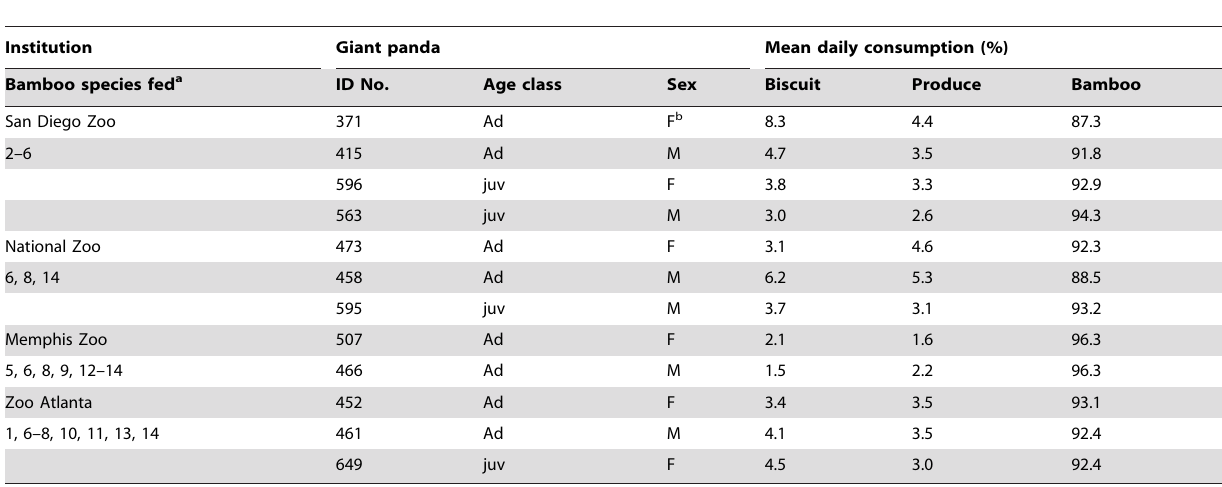
Table 1. Bamboo species offered and mean daily consumption for captive giant pandas ( Ailuropoda melanoleuca ) housed in US